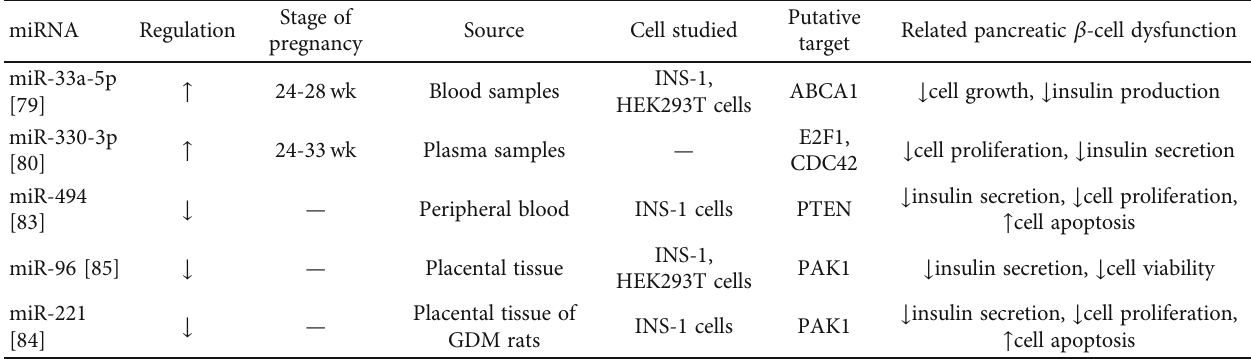
Table 2: Studies investigating the regulation of miRNA and related maternal pancreatic β -cell dysfunction in GDM.